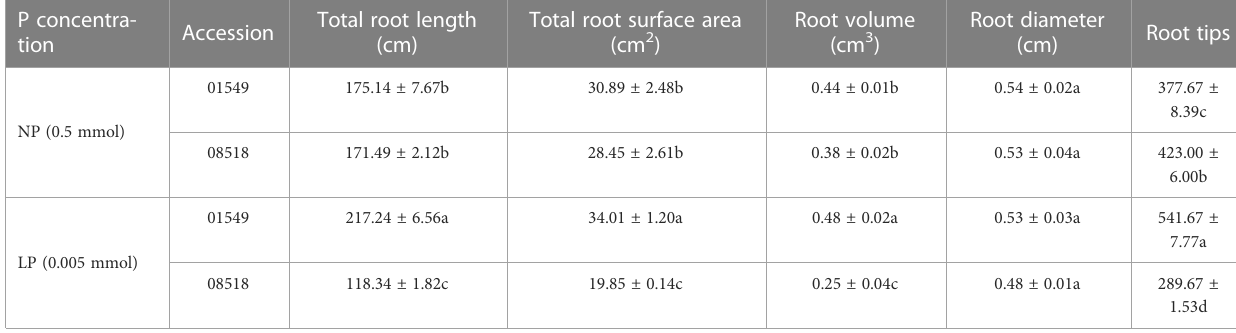
TABLE 2 Effects of L. corniculatus lines on root morphology under low phosphorus stress.